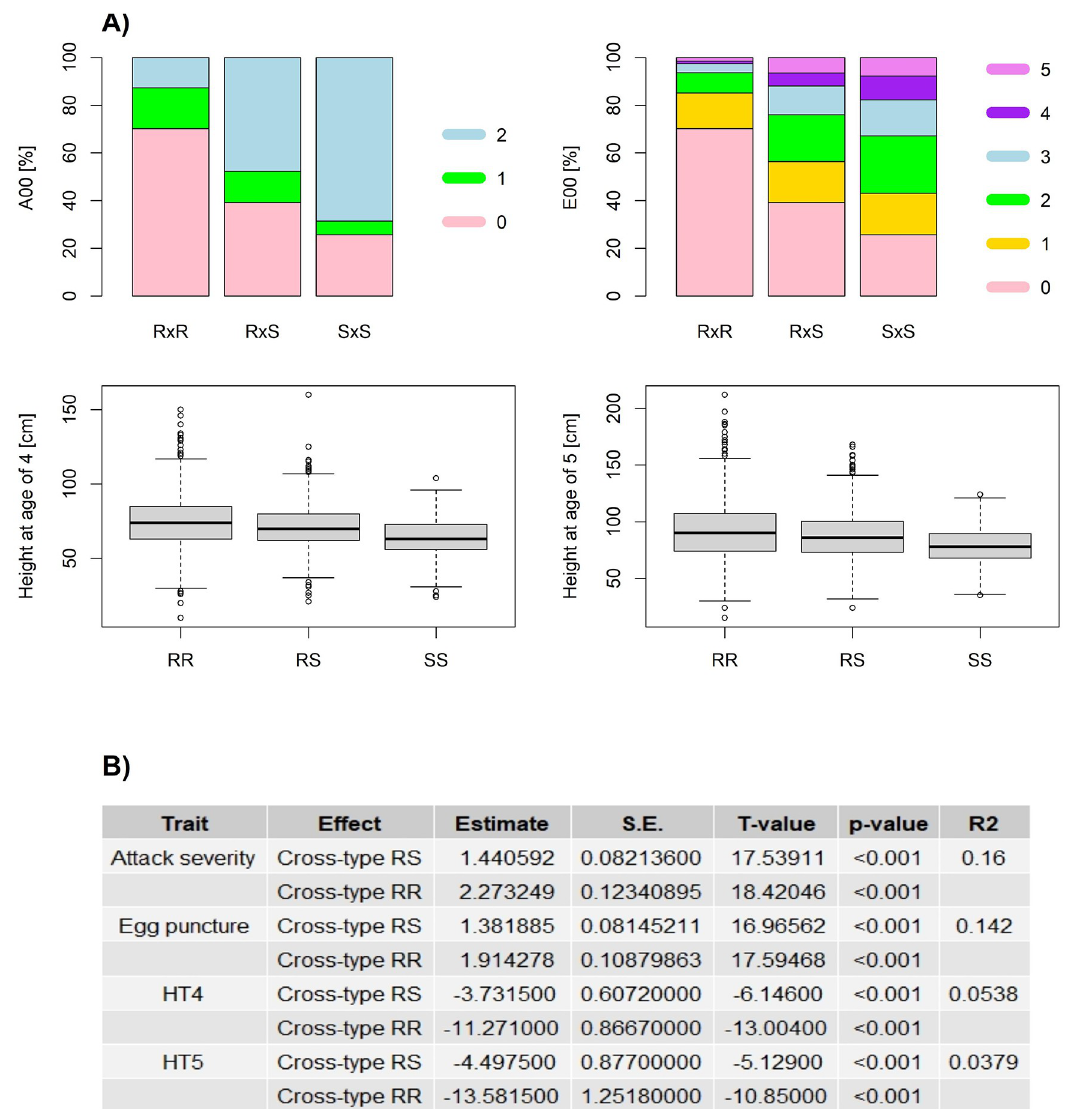
Fig 2. Phenotypic distributions of attack severity, egg puncture occurrences and pre-attack heights within cross-types and their significance. A) Stacked bar charts for weevil attack severity (left, upper plot) and egg puncture occurrence (right, upper plot) in Interior spruce following artificial weevil infestation displayed as the overall percentages for each of the indicated severity levels per cross-type (RxR, RxS, SxS). The colour code for ascending phenotypic values (that is for classes of attack severity, egg punctures occurrence) is provided to the right of both plots. Furthermore, the boxplots diagrams depicting the dispersion of pre-attack heights at 4 years (left, lower plot) and 5 years of age (right, lower plot) are shown for each cross-type of the Interior spruce weevil resistance screening trial. The box in each box plot shows the quartile and the median values of the phenotype dispersion. The whiskers show the range of the phenotypic variation in the individual cross-types. Outliers are depicted as points. B) Statistical significance is shown for cross-type effect on each investigated trait; HT4, HT5: height at 4 years and 5 years of age, respectively; S.E. represents the standard error for the estimates and R 2 the proportion of total variance explained by the model as pseudo R 2 for ‘Attack severity’ and ‘Egg puncture’ and as classical R 2 for ‘HT4’ and